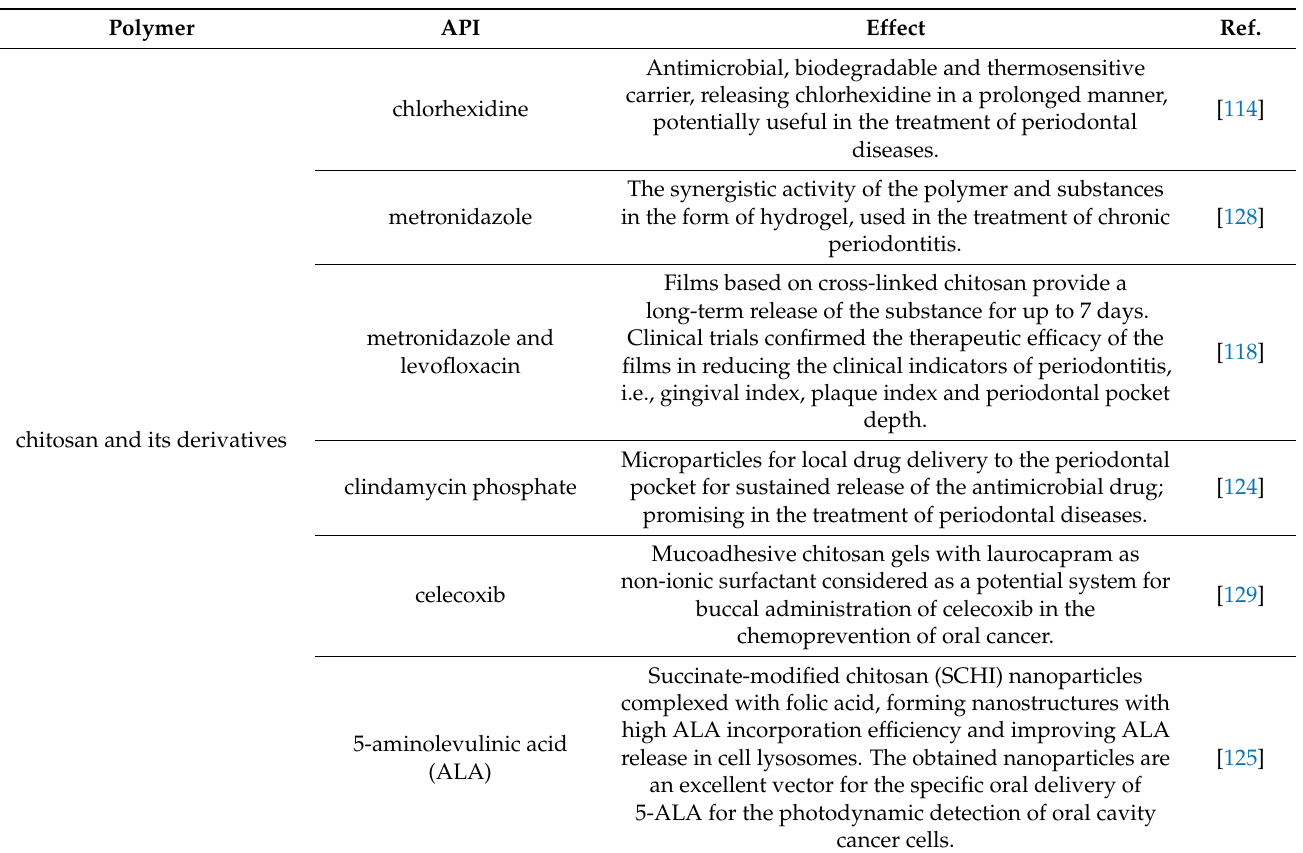
Table 1. The examples of active pharmaceutical ingredient (API) carriers based on natural polymers, used for local applications in therapies for oral cavity diseases. Polymer API Effect